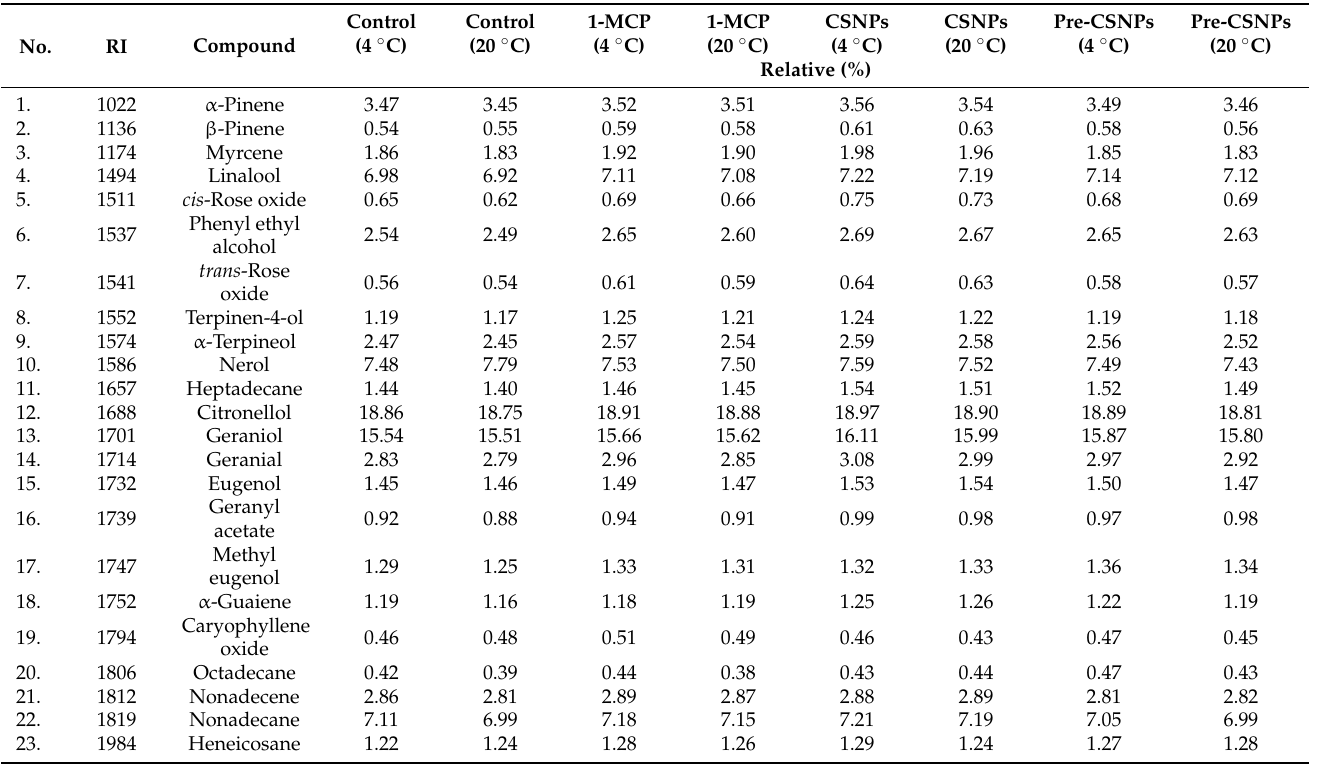
Table 1. GC-MS analysis of damask rose cut flowers stored at 4 or 20 ◦ C and treated with 1-MCP and pre- and post-chitosan nanoparticles